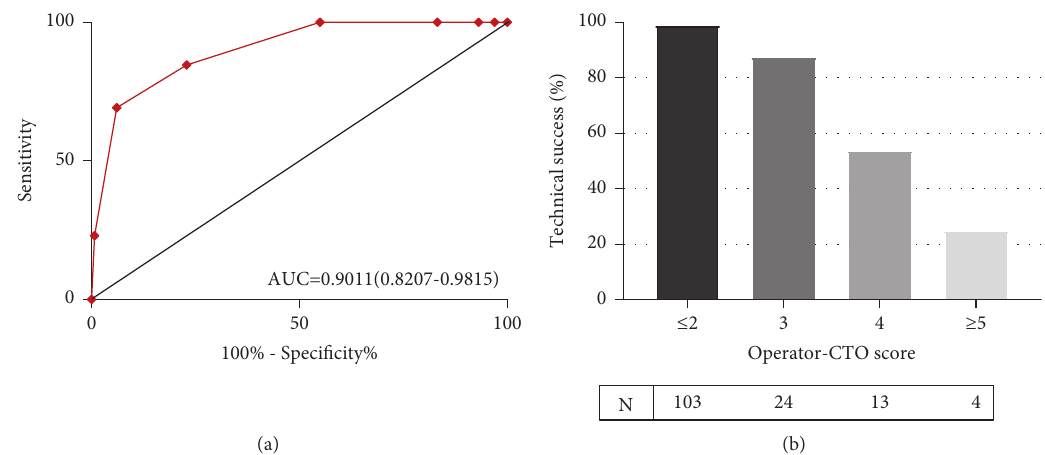
Figure 1: (a) Operator work curve. AUC � 0.9011 (95%CI: 0.821 − 0.982, P < 0 . 01). (b) The relationship between operator-CTO score and technical success.